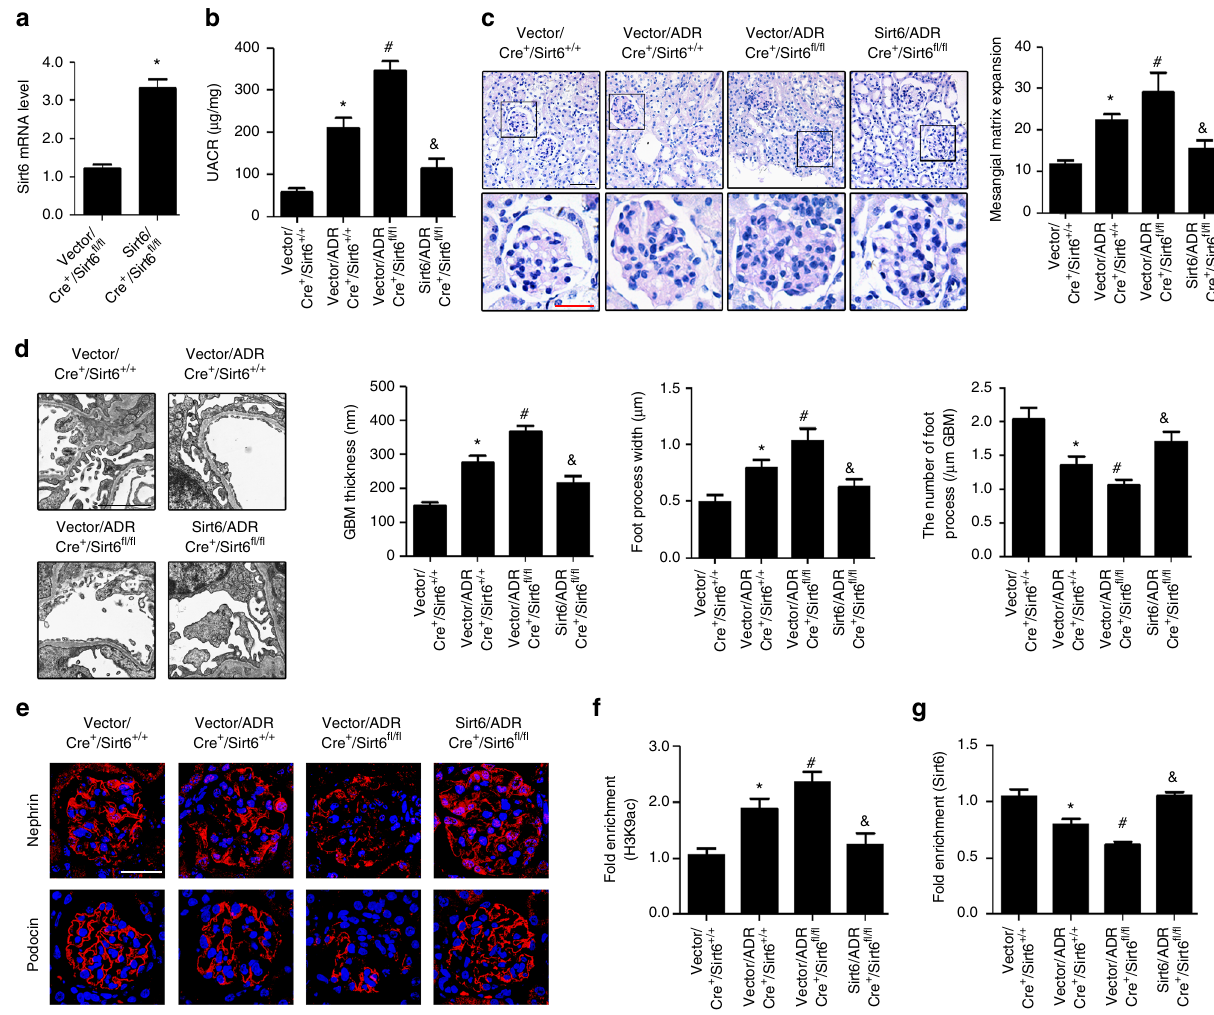
Fig. 9 In vivo overexpression of Sirt6 by intrarenal lentiviral gene delivery ameliorates renal injury in Cre + /Sirt6 fl / fl mice with ADR nephropathy. a The relative mRNA levels of Sirt6 in isolated glomeruli at 5-week after pGLV3- Sirt6 delivered into the mouse kidney by means of intraparenchymal injections. b UACR (urine albumin-to creatinine ratio) in different groups of mice. c Photomicrographs and quanti fi cations showing typical changes in glomerular structure in different groups of mice. Scale bar : black 50 μ m, red 25 μ m. d Representative photomicrographs and quanti fi cations of mean glomerular basement membrane (GBM) thickness, mean foot process width, and the number of foot processes in different groups of mice. Scale bar , 2 μ m. e Representative confocal microscopic images showing the expressions of nephrin and podocin in podocytes from different groups of mice. Scale bar , 25 μ m. f ChIP analysis showing the acetylation levels of H3K9 (H3K9ac) in the promoter of Notch1 using antibodies to H3K9ac in isolated glomeruli. g ChIP analysis showed that Sirt6 bound to promoters of Notch1 by using antibodies to Sirt6 in isolated glomeruli. * P < 0.05 vs. control (vector/ Cre + / Sirt6 + / + mice), # P < 0.05 vs. vector/ADR/ Cre + / Sirt6 + / + mice, & P < 0.05 vs. vector/ADR/ Cre + / Sirt6 fl / fl mice. ( n = 8.) Data are expressed as means ± SE. Student ’ s t -test was employed for comparisons between two groups; one-way ANOVA followed by Tukey ’ s post-test for multiple comparisons was used for